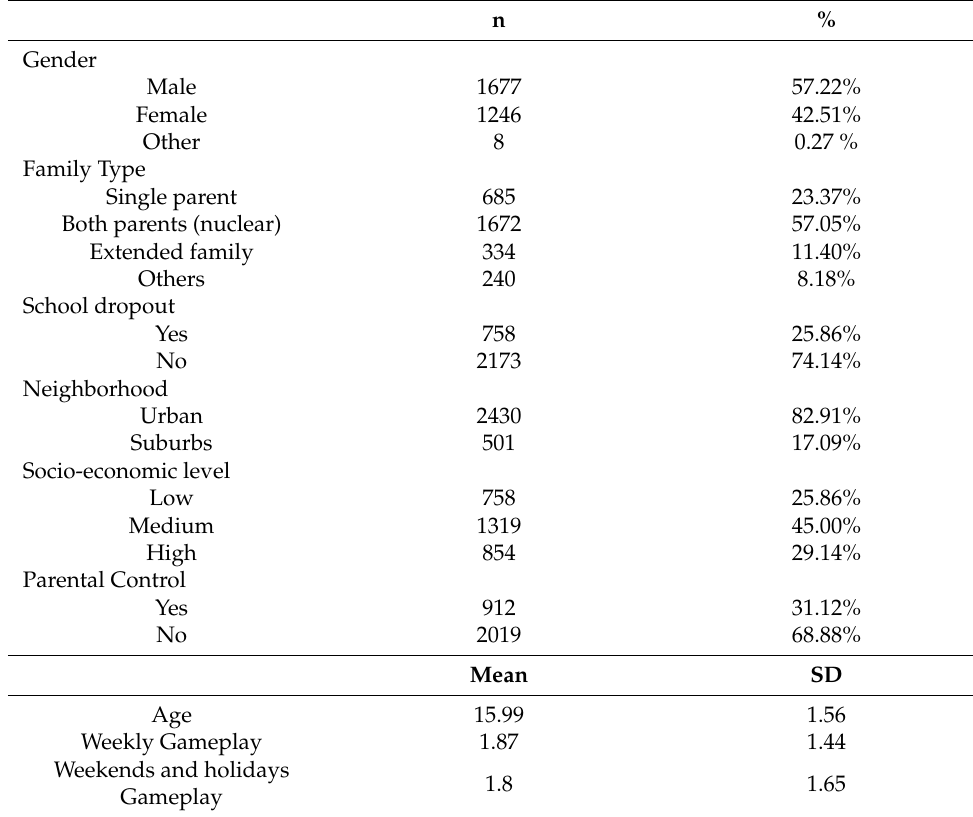
Table 2. Socio-demographic characteristics of the